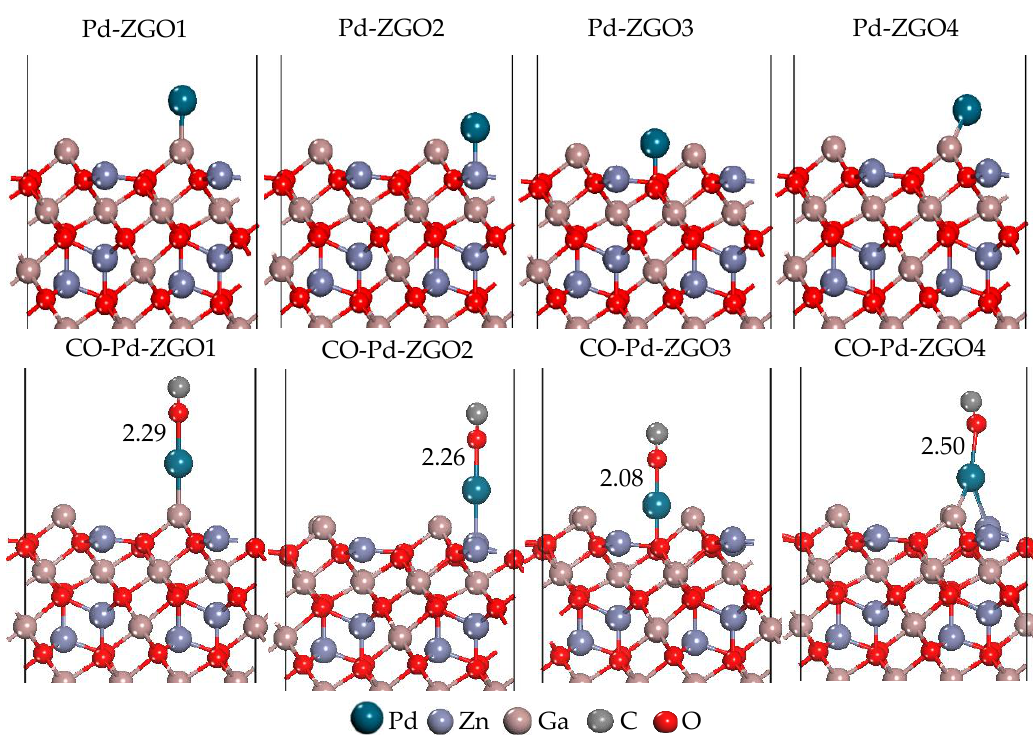
Figure 3. Ball and stick structural representations of the optimized Pd-ZGO i and CO-Pd-ZGO i considered in this study. Atoms are represented by spheres: Pd (dark green, very large), Zn (gray, large), Ga (brown, large), C (gray, medium-sized), and O (red, small). Bond lengths are given in Å .